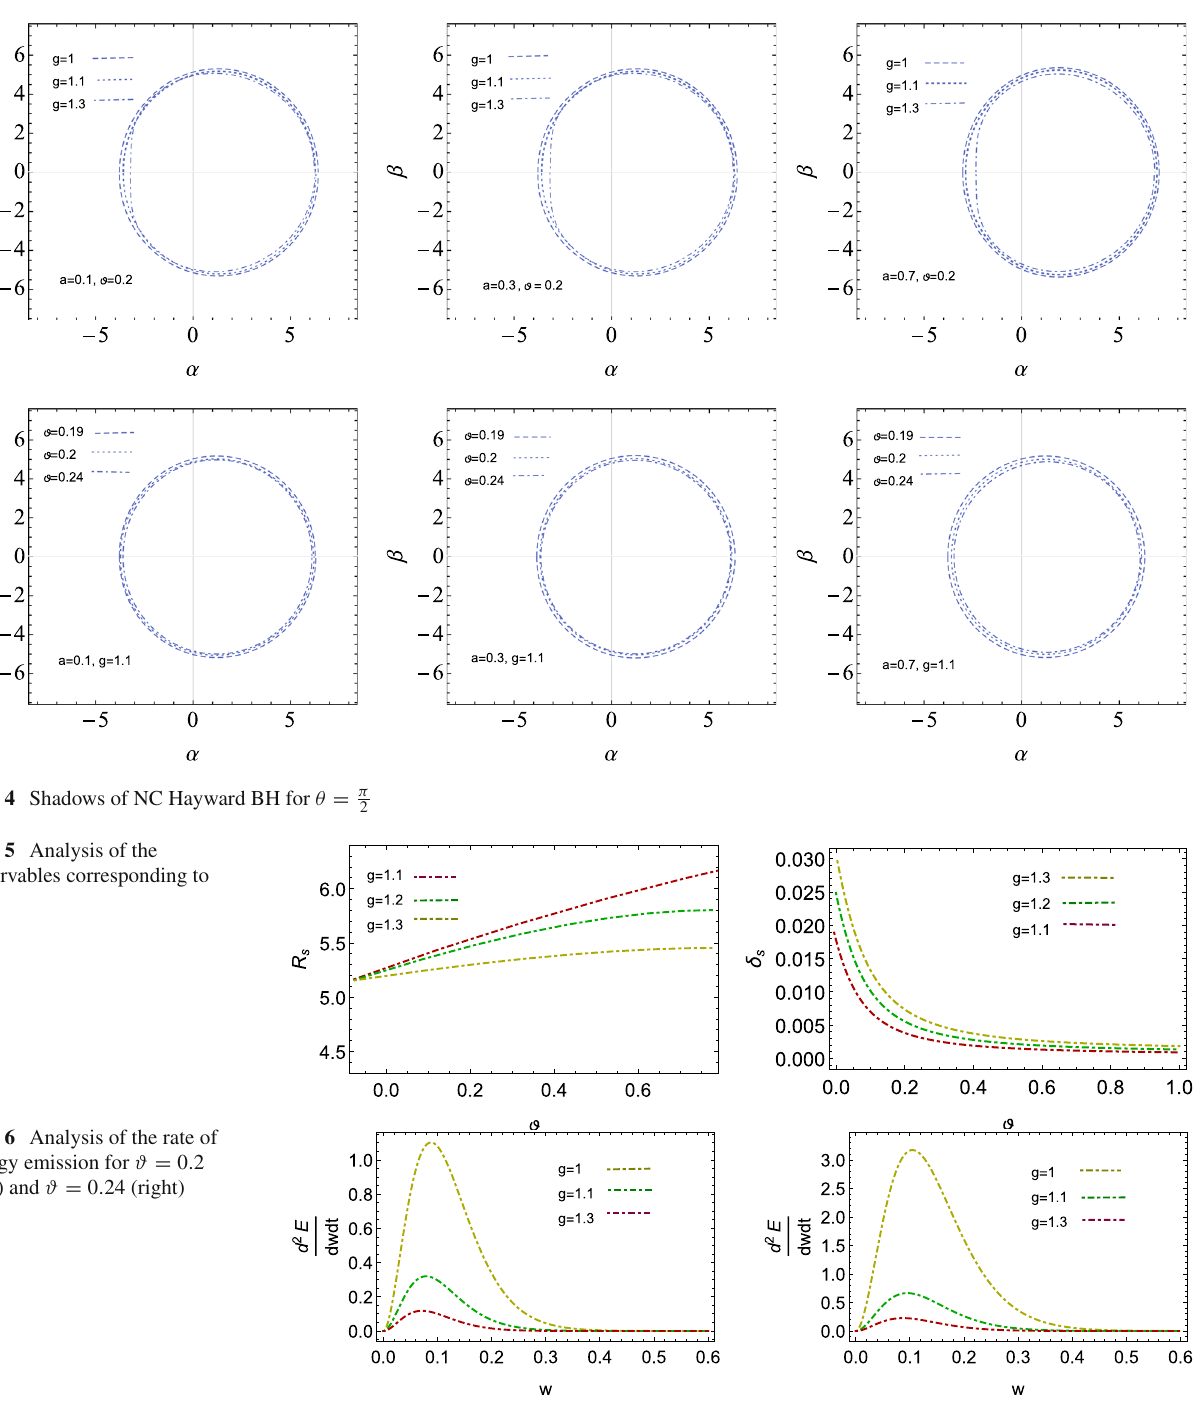
Fig. 6 Analysis of the rate of energy emission for ϑ = 0 . 2 (left) and ϑ = 0 . 24